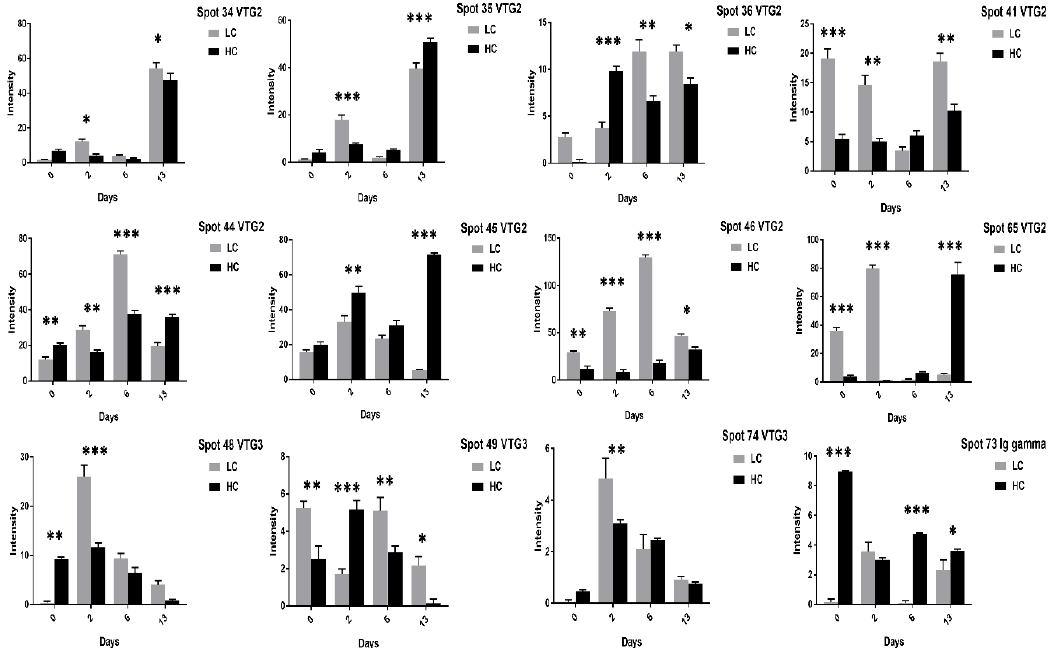
Figure 12. A comparison of low and high cholesterol egg yolk proteins (VTG-2, VTG-3, and Ig gamma) spots after 0, 2, 6, and 13 days of incubation was performed. The column profiles of VTG-2, VTG-3, and Ig gamma are shown as bar charts with significant differences. The data represent the mean values of three replicates and the error bars denote the standard deviation. * p < 0.05, ** p < 0.005, *** p < 0.0001.